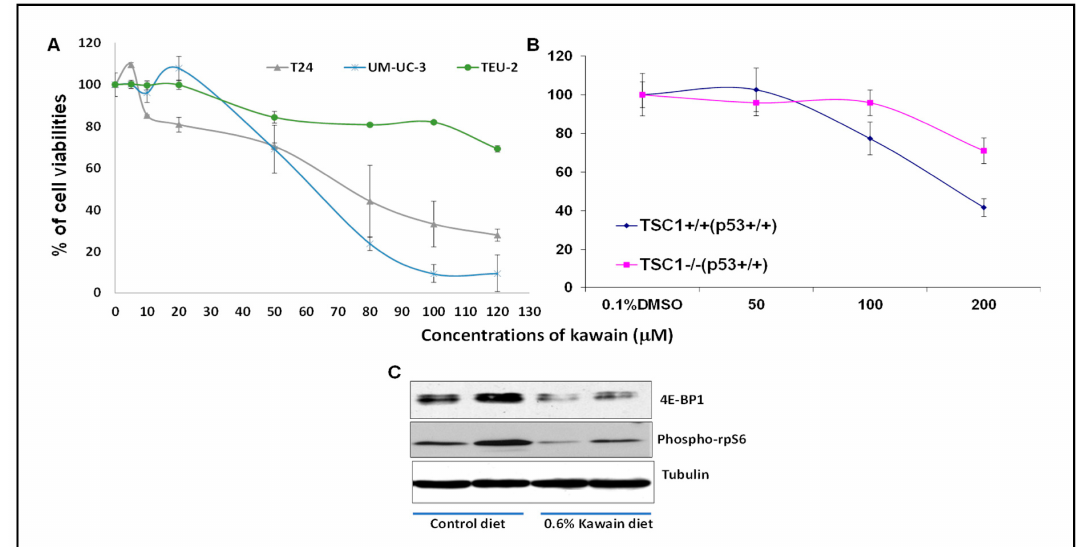
Figure 5. The growth inhibitory efficacies of kawain are related to its inhibition of the mTOR signaling. ( A ) Growth inhibitory efficacies of kawain on the growth of T24, UMUC3 and Teu-2 cells after treatments with 0.1% DMSO or indicated concentrations of kawain for 72 hours. ( B ) TSC1 knockout MEFs are more resistant to kawain’s cytotoxic effects compared to TSC1 wild-type ones. ( C ) The protein expression levels of the mTOR pathway effectors: 4E-BP1 and phosph-rpS6, in bladder tumor tissues from mice fed with indicated diet were analyzed by Western blotting.